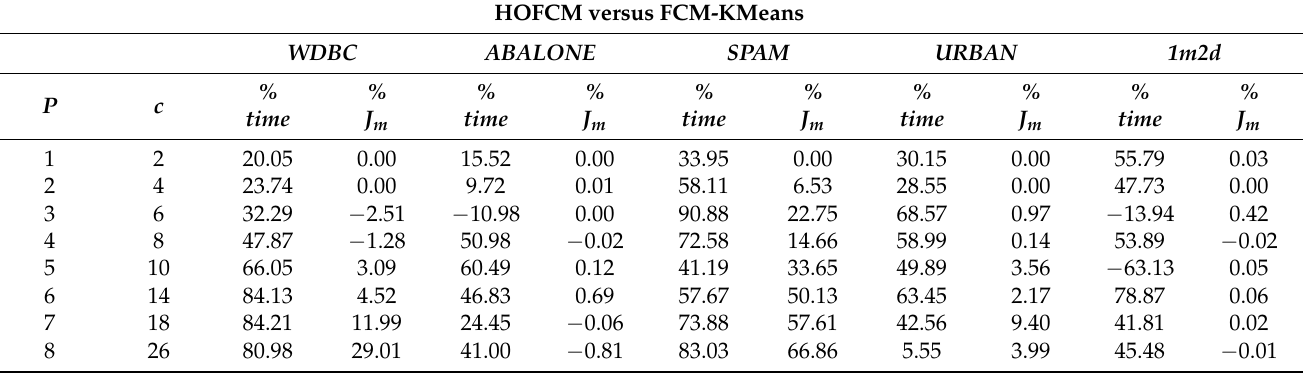
Table 4. Average percentages of time reduction and value of the objective function in Experiment II; HOFCM versus